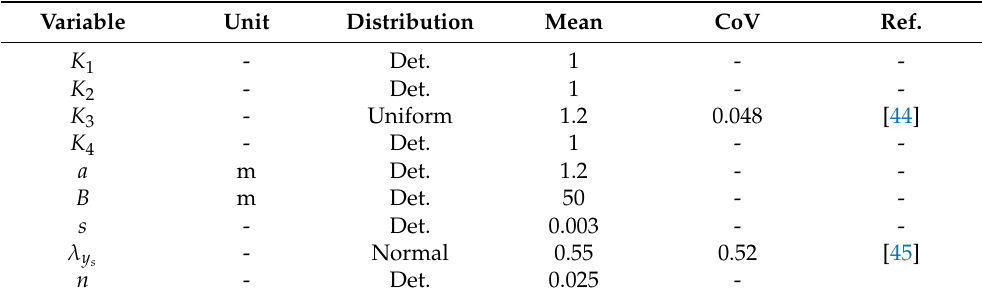
Table 1. Input variables for scour depth